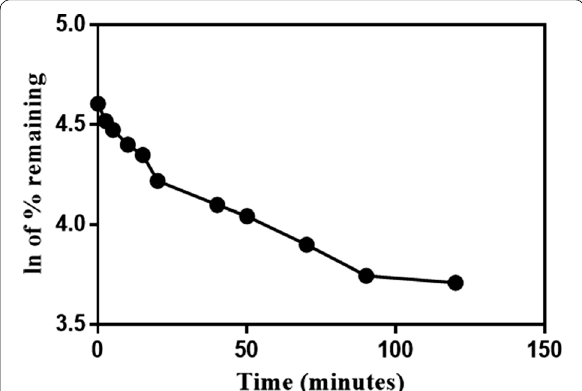
Fig. 6 The metabolic stability profile of